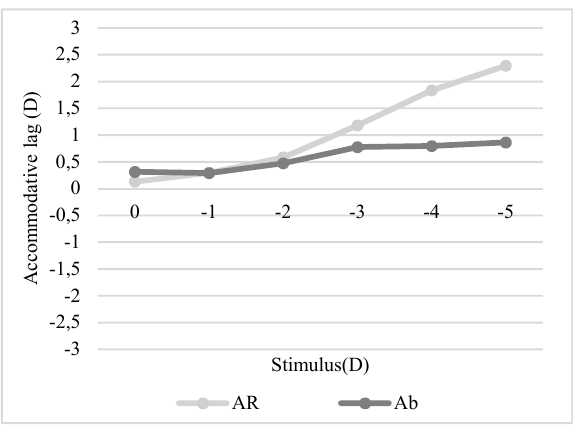
Fig. 2. The accommodative lag measured with open-field autorefractometer (AR) and Hartmann-Shack aberrometer (Ab) for the different lenses (0, -1, -2, -3, -4 and -5 D). Positive values represent accommodative lag and negative values accommodative lead.